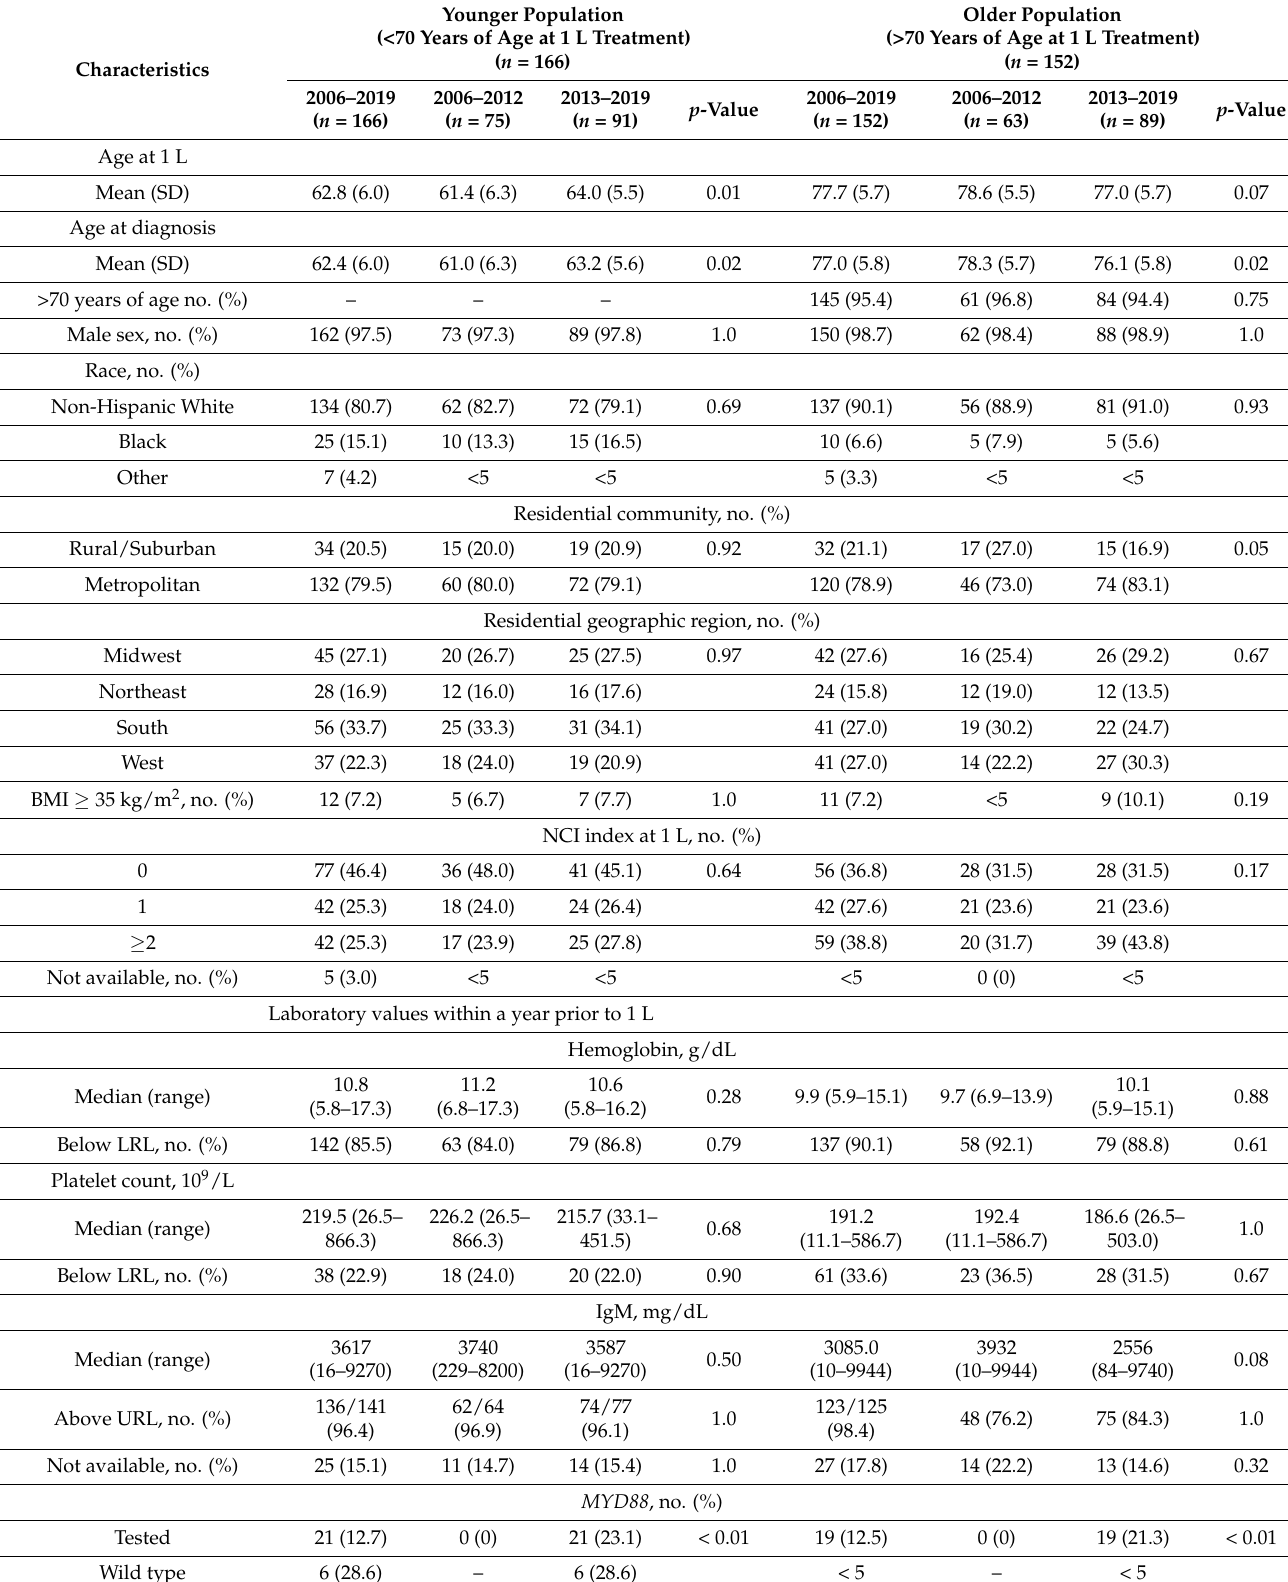
Table 1. Characteristics in veterans receiving treatment for Waldenström macroglobulinemia in Veterans Affairs (VA) from 2006 to